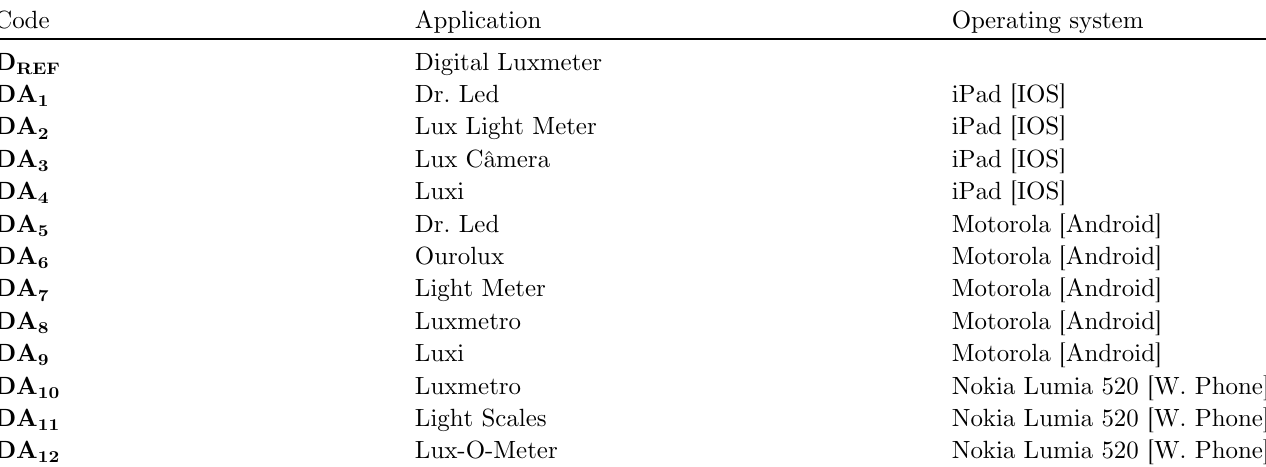
Table 1. Codes for the digital luxmeter measurements and each association of apps and operating systems of mobile devices employed in the study.